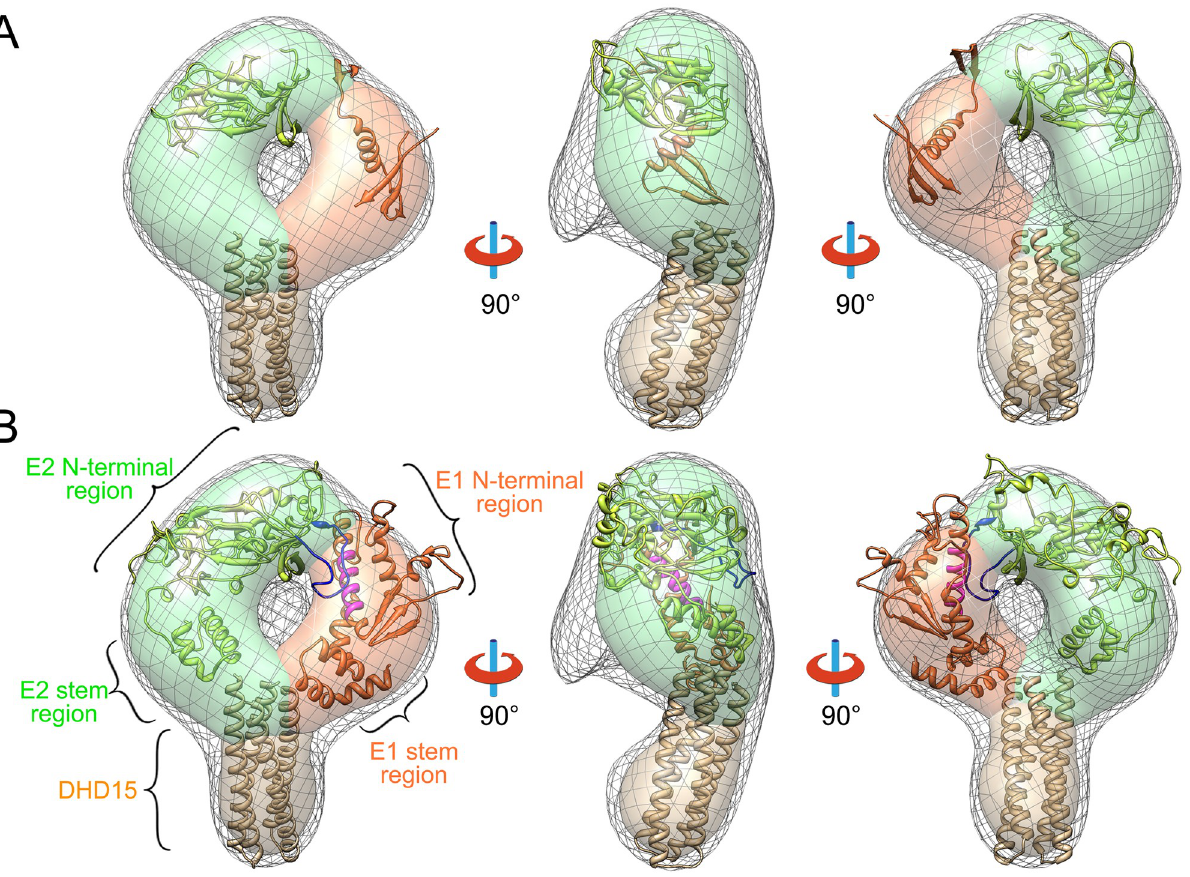
Fig 4. Three-dimensional EM reconstruction and the structural model of HCV E1E2 heterodimer. (A) Three views of the 3D reconstruction of E1E2-DHD15 (low-density contour: gray mesh; high-density contour: surface). The solved structures of E2 (PDB entry: 4MWF, green), E1 (PDB entry: 4UOI, orange) and DHD15 (brown) are put into the EM density showing that a large portion of E1 and E2 are missing in the known crystal structures. The densities corresponding to E2, E1 and DHD15 are colored in green, orange and brown in the high-density contour, respectively. (B) Three views of the coevolution based E1E2 structural model fitted into the EM reconstruction. The hyper variable region 2 (HVR2, blue) of E2 and the putative fusion peptide (magenta) of E1 are shown in the structural model.